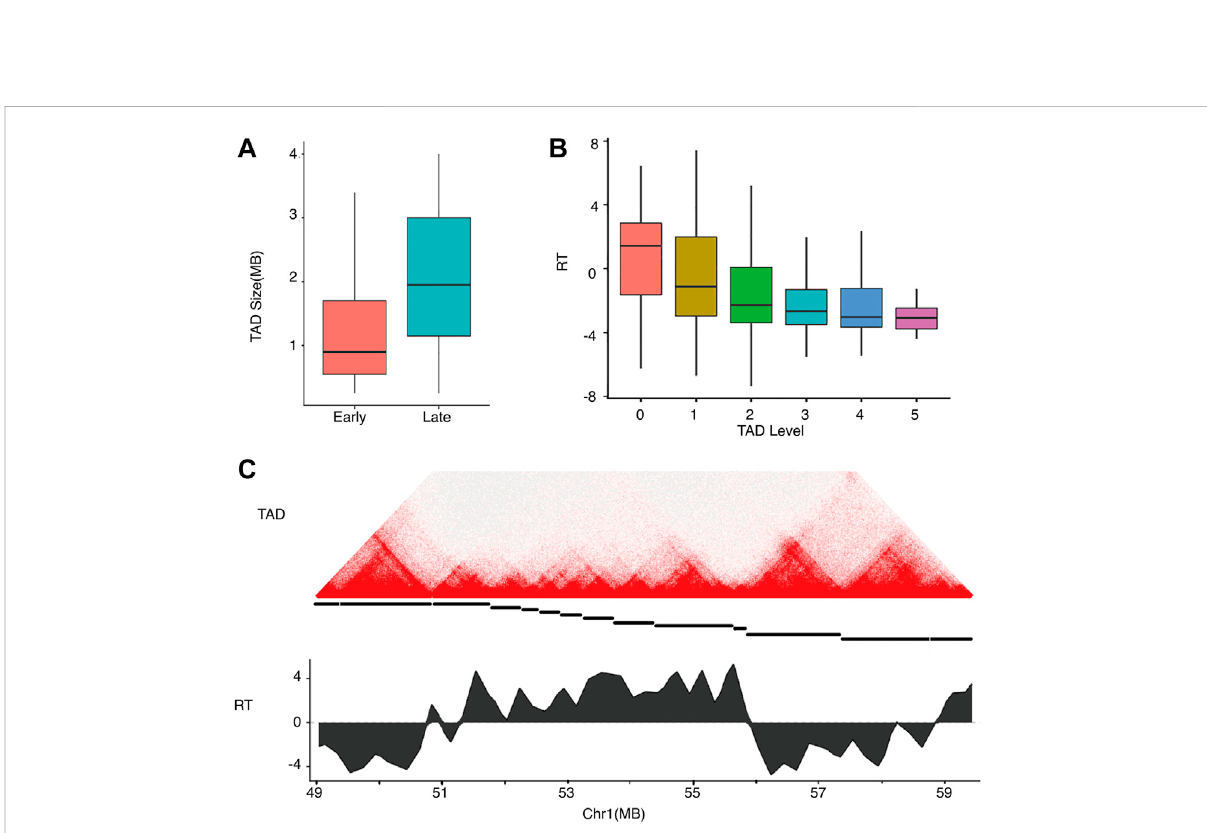
FIGURE 4 Relationships of replication timing and TAD size and hierarchy in hESC. (A) TAD size distributions of early and late RDs. (B) RT distributions of TADs in differential levels. (C) An example showing a local Hi-C heatmap and RT on chromosome 1. Top: heatmap with colors representing Hi-C contacts.Middle:TheTADstructureisdenotedbydisconnectedhorizontallines.Bottom:RTpro fi